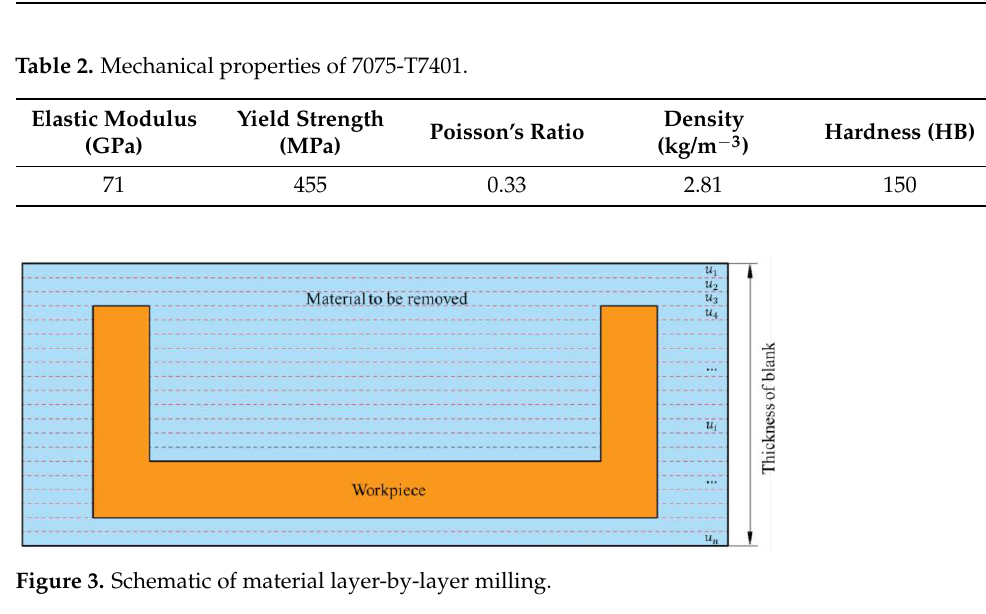
Figure 4. Initial residual stress model. The relationship between the strain energy and removal amount obtained by the FEM is shown in Figure 5a. The study found that with the continuous progress of machin- ing, the residual strain energy in the workpiece showed a changing trend of “ severe de- crease — gentle decrease — severe decrease ” to a certain extent. For the aircraft beam stud- ied in this research, when the material removal amount was in the range of 0~0.3 mm and 0.5~0.8 mm, the strain energy in the material was in a severe drop stage. In this process, the stage where the removal amount was less than 0.3 mm is defined as the first severe energy drop stage, and the stage where the removal amount was between 0.5 mm and 0.8 mm is defined as the second severe energy drop stage. However, when the material re- moval amount of the workpiece was between 0.3 mm and 0.5 mm, the decreasing trend of the strain energy in the blank was relatively gentle, and this stage can be defined as the steady energy drop stage. ( a ) ( b )